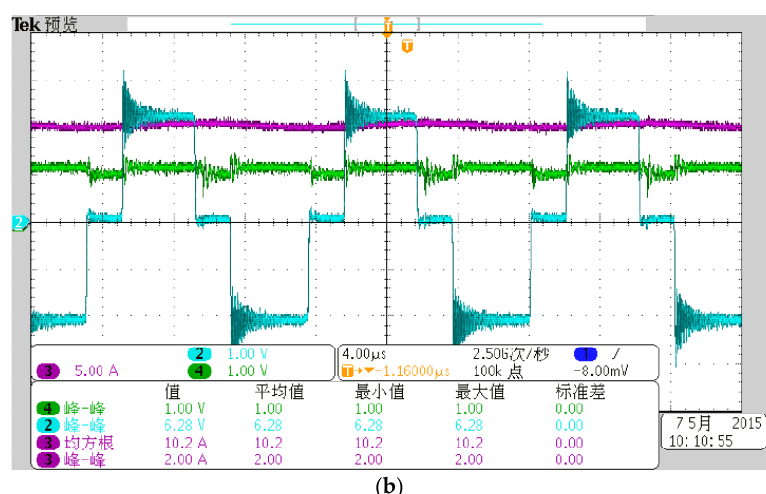
Figure 15. Purple curve: the charging currents for the battery pack; green curve: the input voltage of the q ‐ Zsource; cyan curve: the output voltage produced by the H Bridge measured ( a ) at the 1 μ s shoot ‐ through time; and ( b ) at the 1.5 μ s shoot ‐ through time.